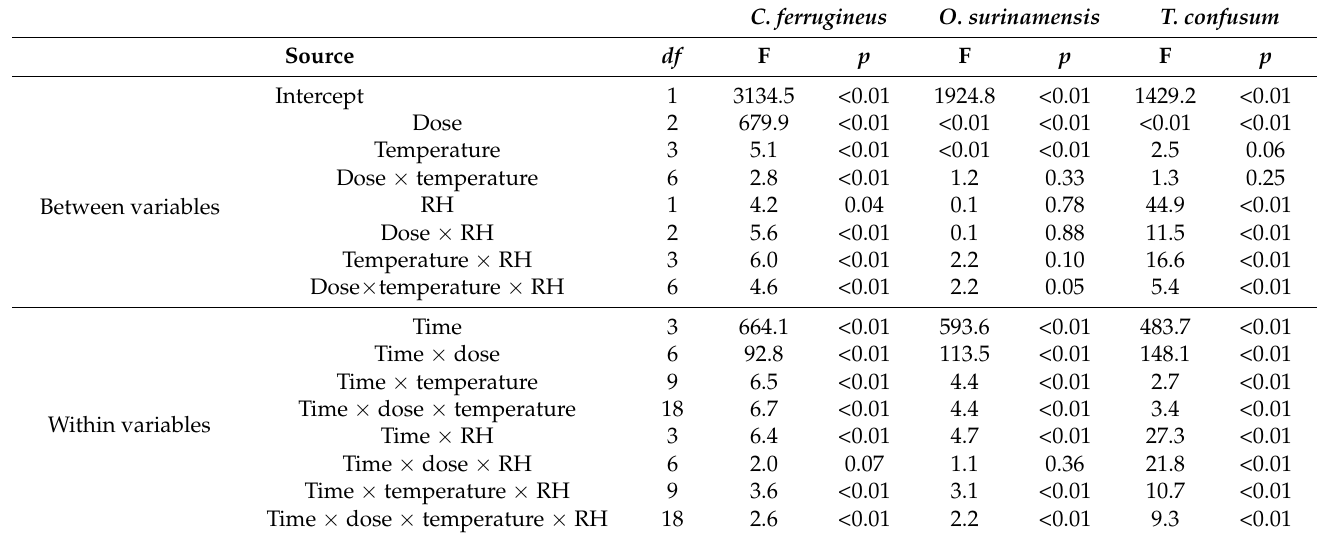
Table 1. Repeated measures MANOVA parameters for mortality levels of C. ferrugineus, O. surina- mensis , and T. confusum adults between exposure intervals (error df = 108).